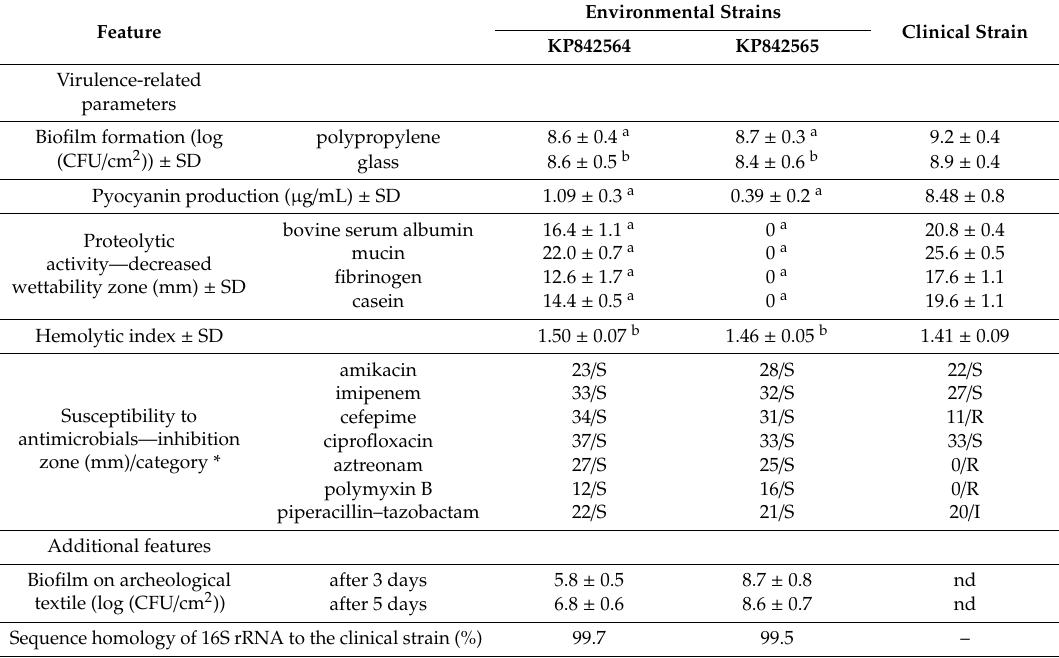
Table 2. Characteristics of the clinical strain of P. aeruginosa and the environmental strains isolated from archeological